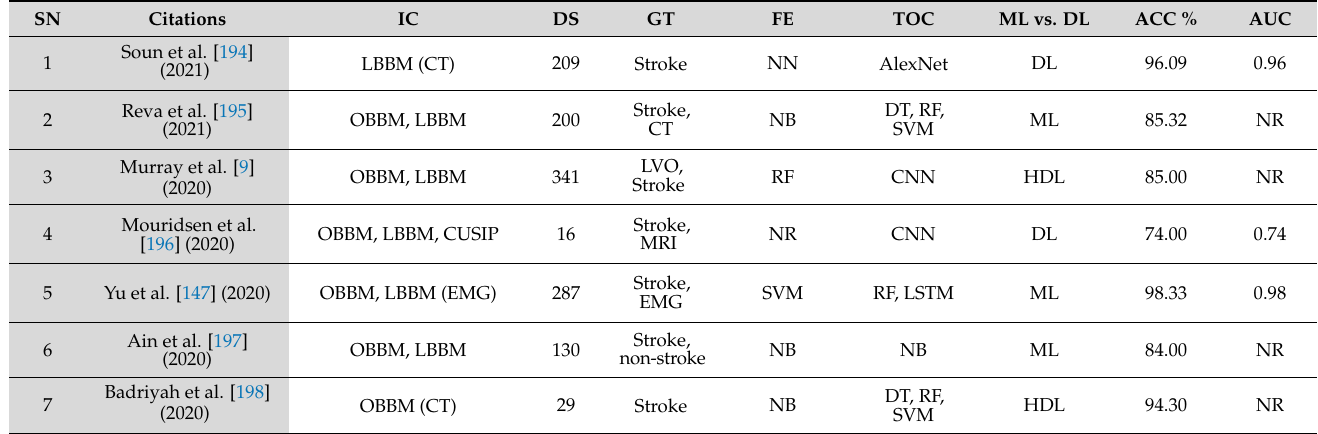
Table 4. The table shows the prediction of stroke by using AI.